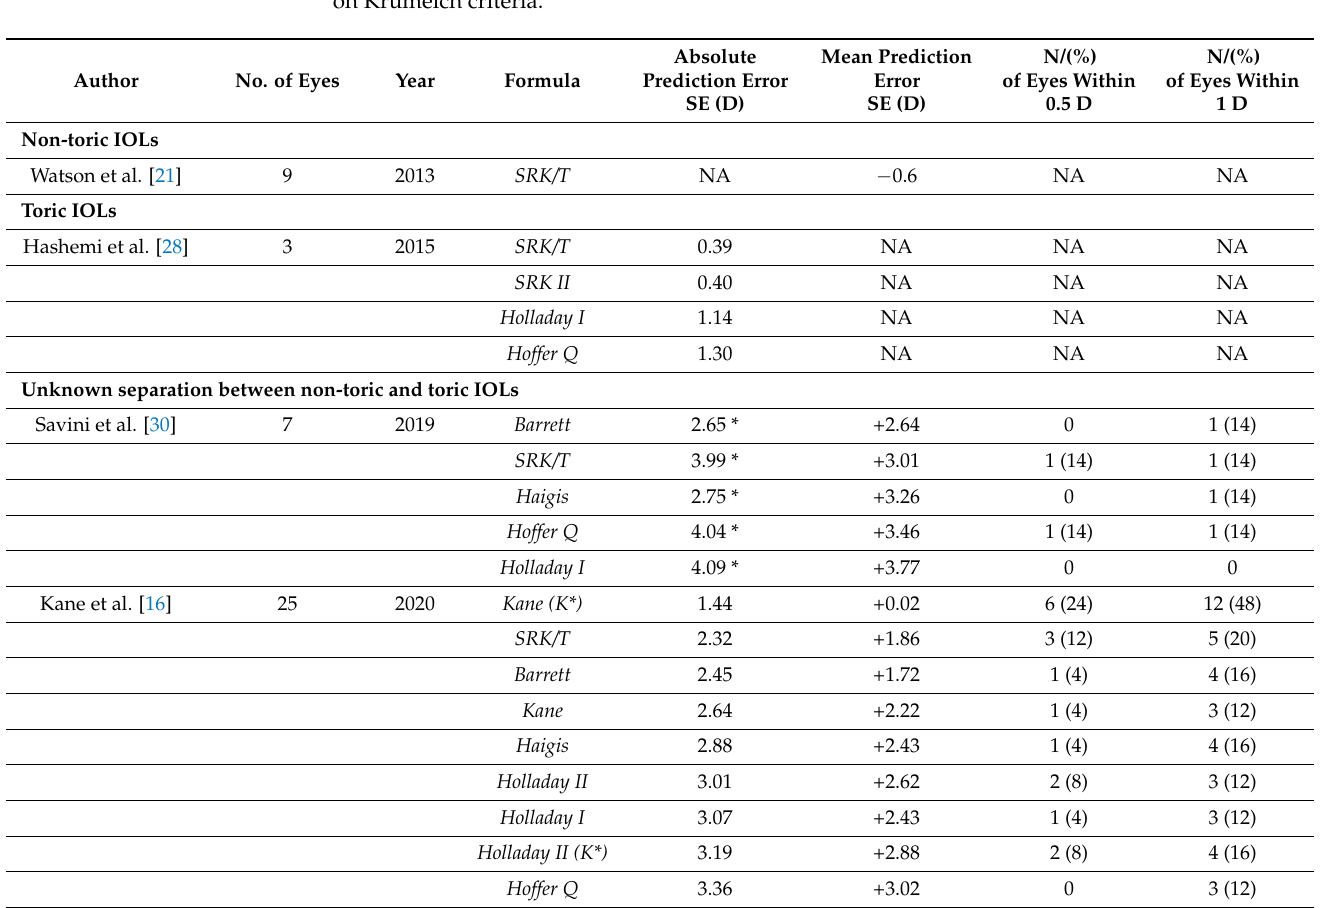
Table 4. Mean error in non-toric and toric IOL power calculation in keratoconus stage III eyes based on Krumeich